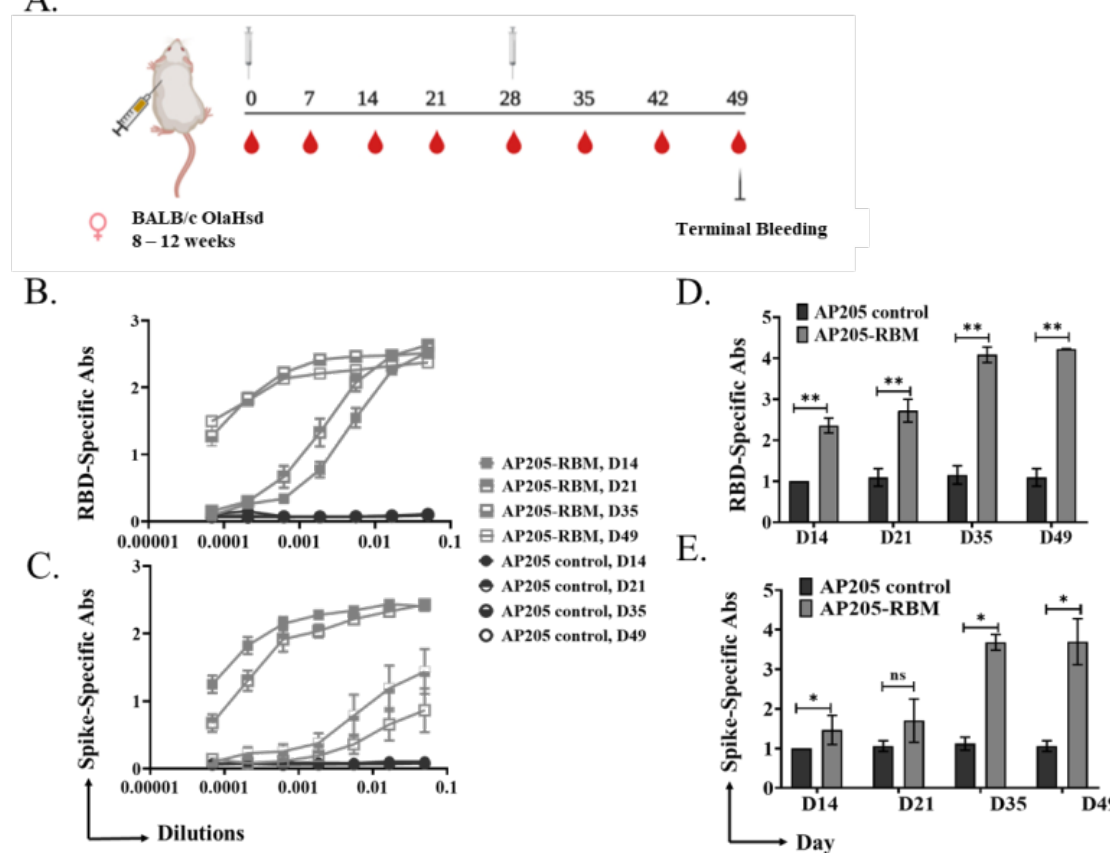
Figure 2. Vaccination with AP205-RBM vaccine induces high titer of RBD and Spike-specific IgG Abs. ( A ) Vaccination regimen and bleeding schedule. ( B , D ) RBD-specific IgG titer for the groups vaccinated with AP205 control and AP205-RBM vaccine on days 14, 21, 35, and 49, measured by ELISA (OD50 in D: given as reciprocal dilution values), three-fold serial serum dilution was used starting from 1:20. ( C , E ) Spike-specific IgG titer for the groups vaccinated with AP205 control and AP205-RBM vaccine on days 14, 21, 35, and 49, measured by ELISA (OD50 in E: given as reciprocal dilution values), three-fold serial serum dilution was used starting from 1:20. One representative of 2 similar experiments is shown. The value of p < 0.05 was considered statistically significant (* p < 0.01, ** p <